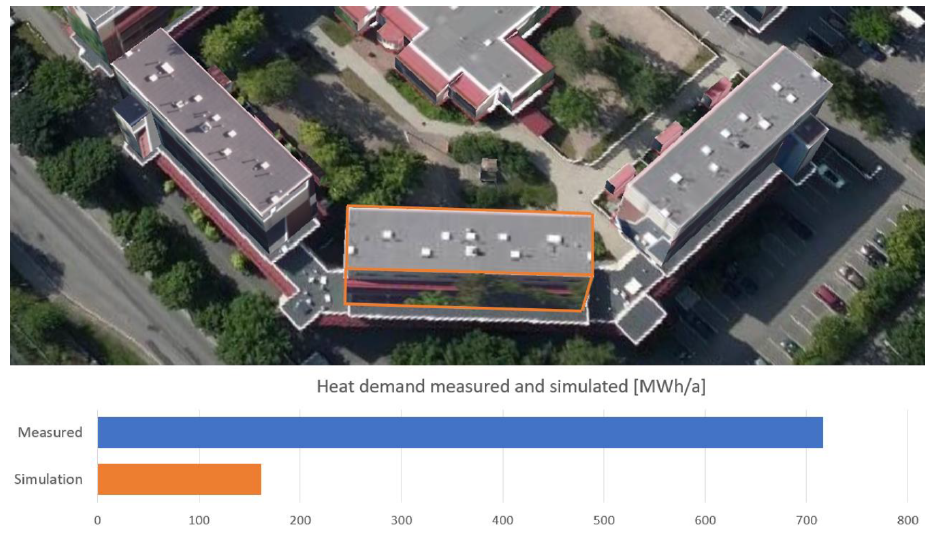
Figure 9. Possible incorrectly mapped heat demand of a